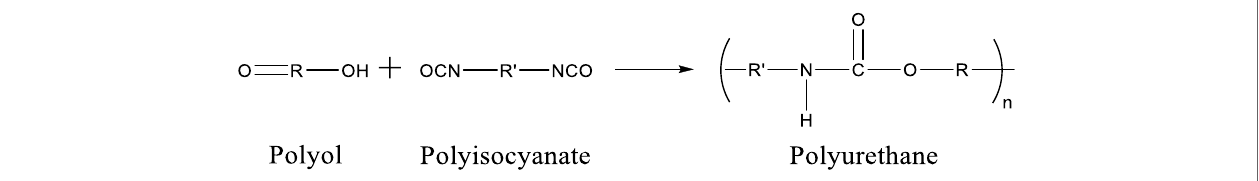
FigUre 1 | Reaction of a polyol with a polyisocyanate to synthesize a polyurethane. FigUre 2 | Structures of a select few isocyanate compounds and polyol compounds.